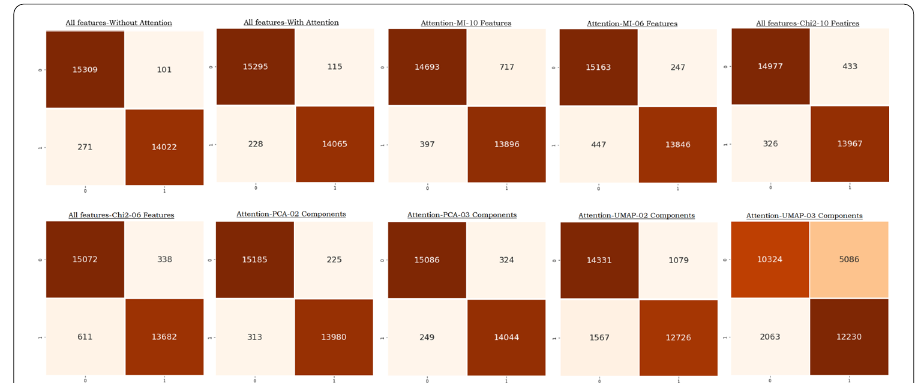
Fig. 13 Confusion Matrices for the proposed models in binary classification